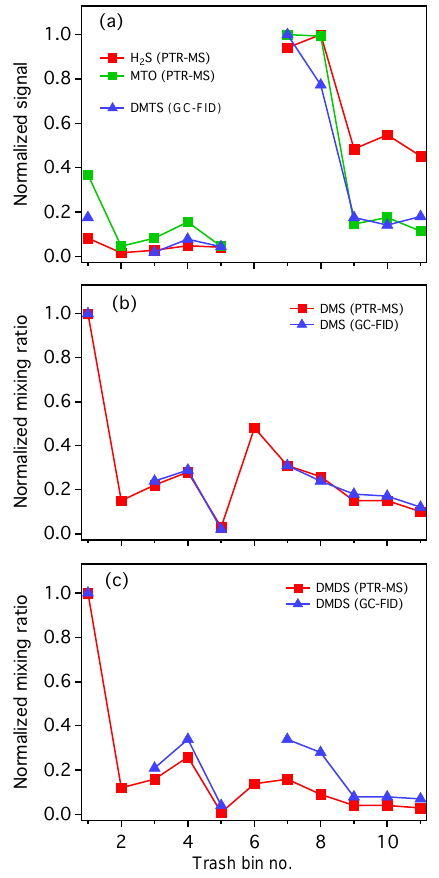
Figure 8. Normalized mixing ratios and signals obtained for all four organosulfur compounds from the source samples including (a) MTO, DMTS, and H 2 S; (b) DMS; and (c) DMDS in different bins. Canister samples were not available for bins 2 and 6. The lines between symbols of individual bins are simply a visual